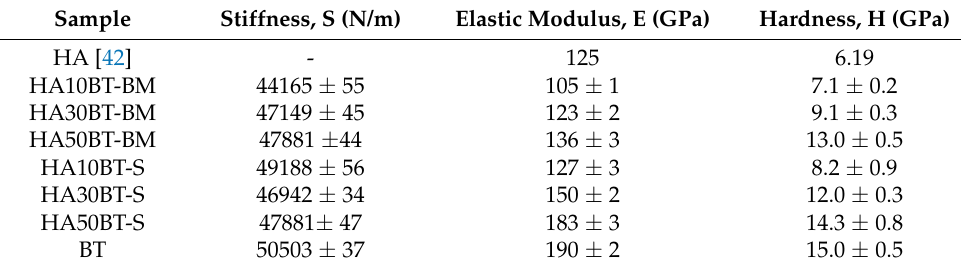
Figure 16. Elastic modulus and hardness as a function of the BT/HA ratio and the powder preparation method ( a ) and ( b ) respectively. Table 5. Stiffness, elastic modulus, and hardness of samples evaluated by nanoindentation.